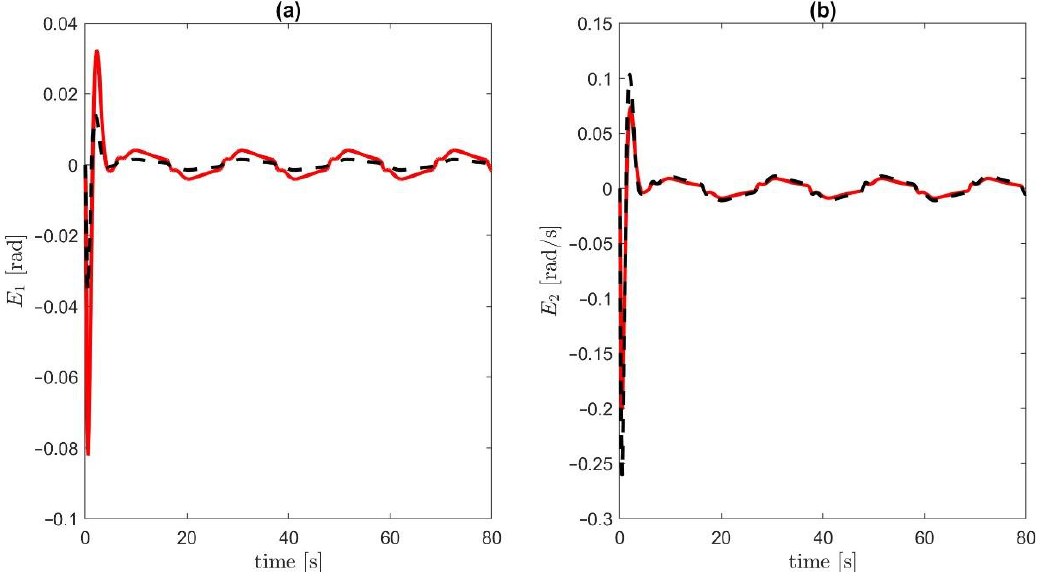
Figure 9. ( a ) Tracking error 𝐸 1 , ( b ) tracking error 𝐸 2 . Dashed black line — 𝑘 1 = 𝑘 2 = 𝑘 3 = 𝑘 4 = 15 , solid red line — 𝑘 1 = 𝑘 2 = 𝑘 3 = 𝑘 4 = 5 .